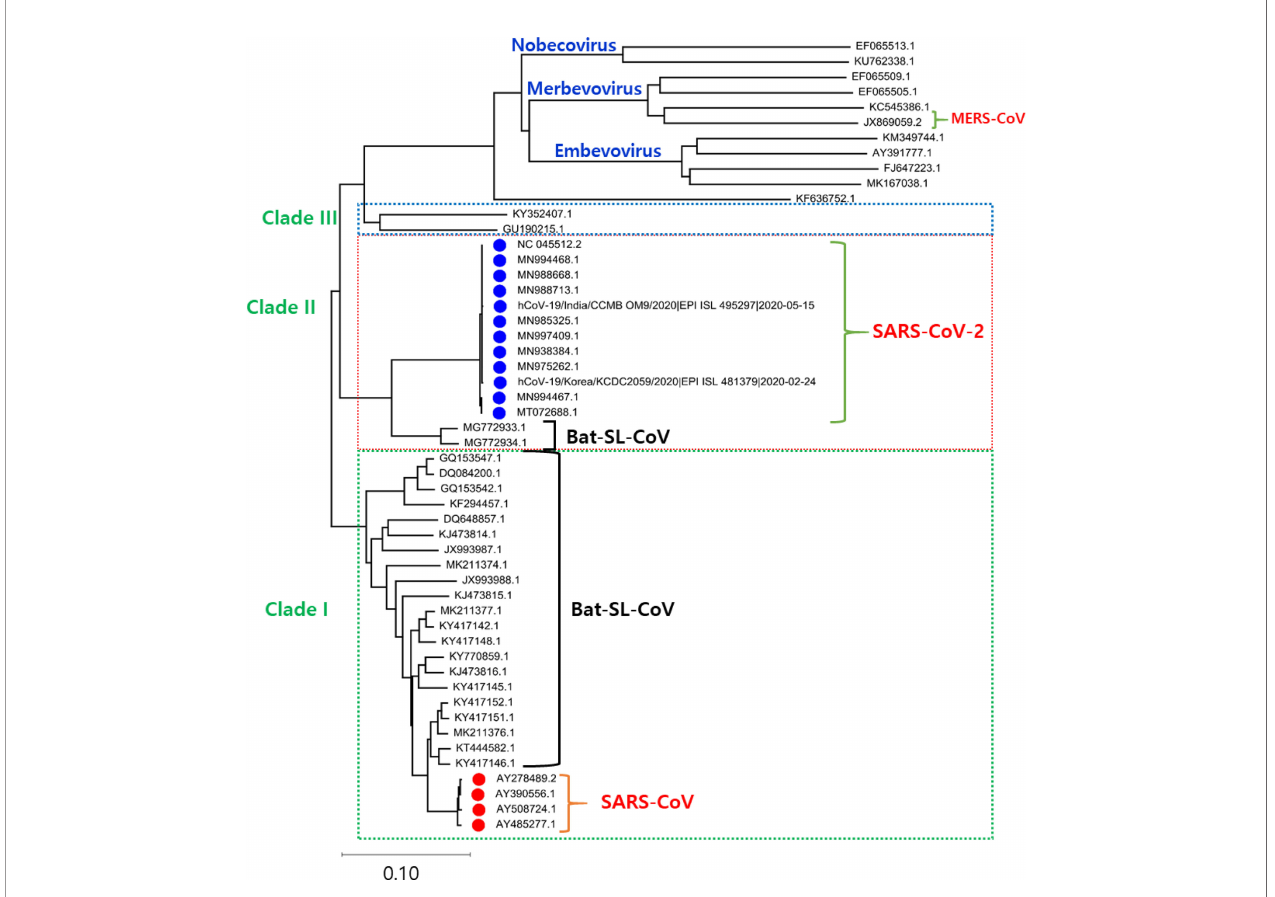
FIGURE 1 | The phylogenetic tree is generated using the latest complete genome sequences of different neighbours, MERS-CoV, Bat-SL-CoV, and SARS-CoV. The tree is divided into three clades according to the grouping of clusters. In Clade I: Bat-SL-CoV-2 and SARS-CoV were showing a close evolutionary relationship with each other. Clade II: A mixture of human and bat coronavirus including the MERS-CoV. Clade III: This clade represents all the SARS-CoV2 genomes isolated from humans, interestingly it is also observed that these genomes are showing a close evolutionary relationship with